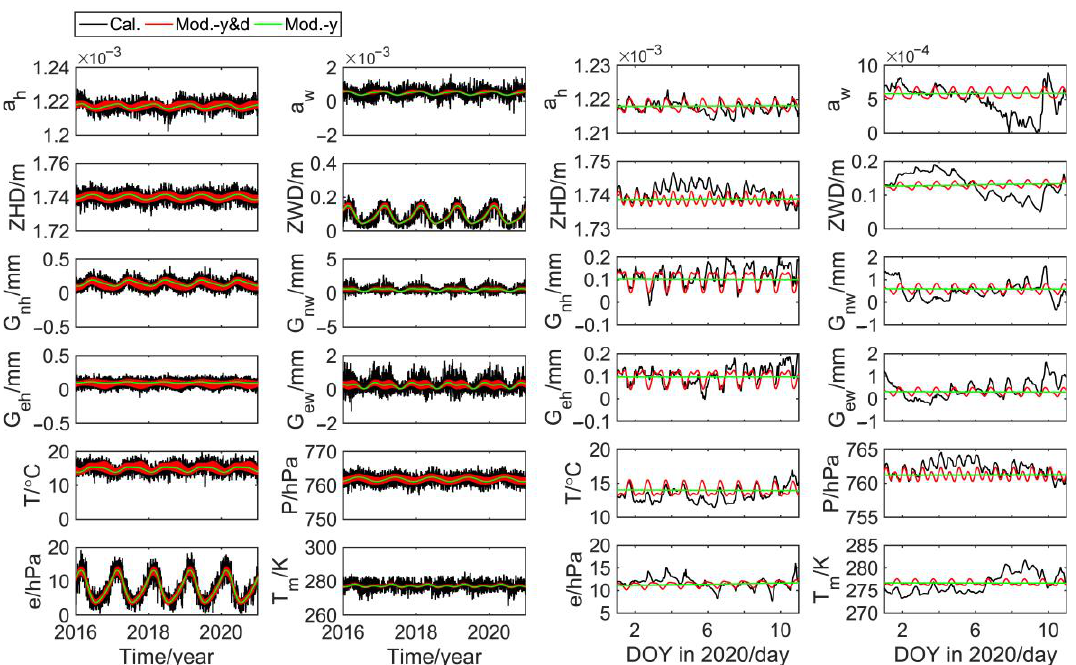
Figure 4. Calculated time series (black line) as well as modeled time series with Equations (9) (red line) and (6) (green line) for the AREG station. The left two columns show the 5-year time series, and the right two columns are the 10-day zoom in time series.